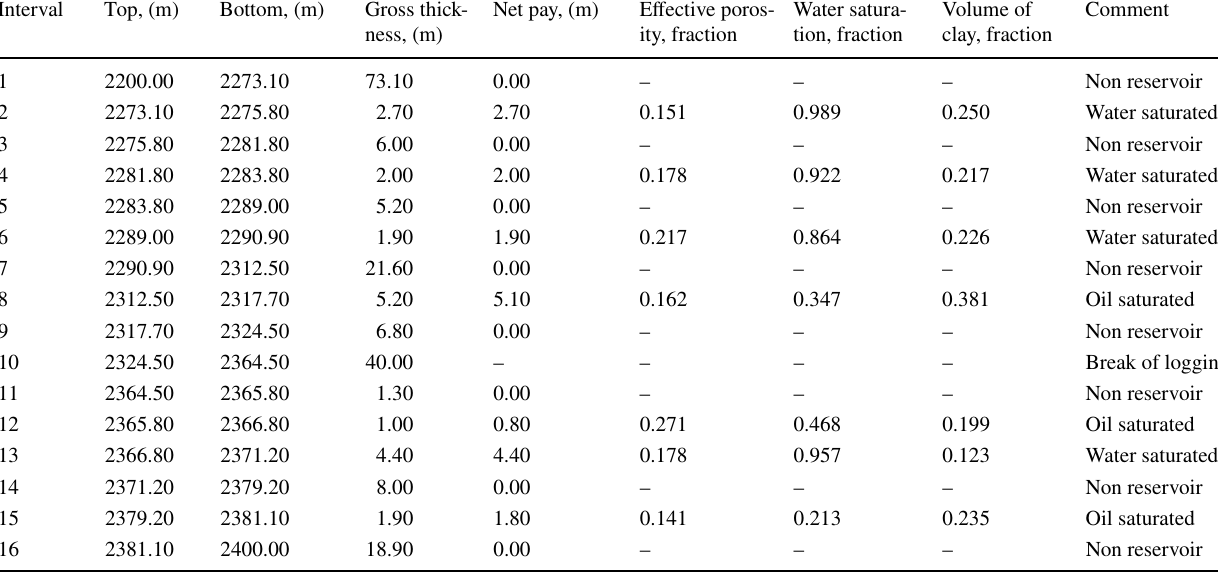
Table 3 Wireline logs interpretation for Paleocene deposits of Well # 7 Blagodarnenskaya Interval Top, (m)